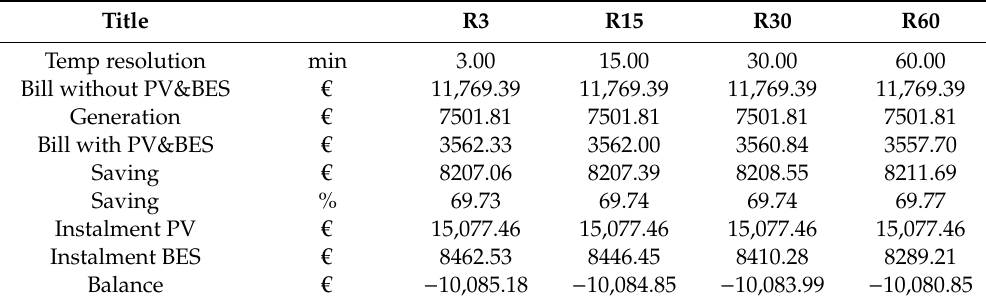
Table 4. Bills and